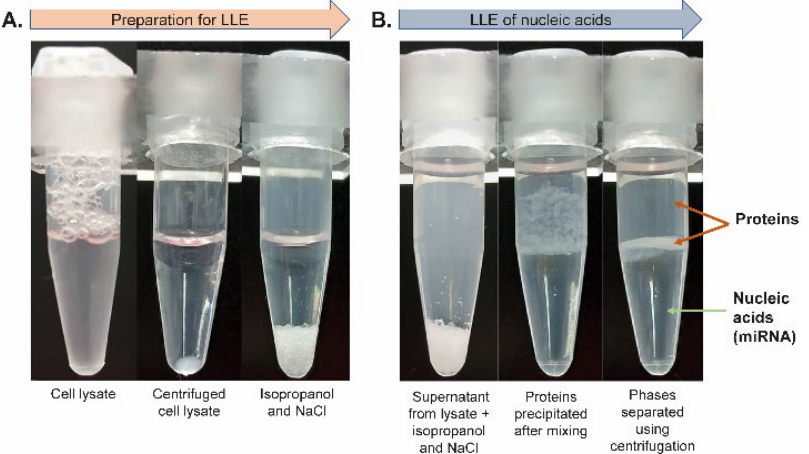
Figure 3. Liquid–liquid extraction of RNA from cell lysate. ( A ) Cell lysate (Jurkat cells) before and after centrifugation and tube with NaCl and isopropanol, ( B ) first tube containing isopropanol/NaCl mixed with cell lysate supernatant before incubation on a rotator, second tube after incubation step, and third tube after the final centrifugation step (top phase is organic; interphase is formed by precipitated proteins; and bottom, aqueous phase contains RNA molecules).